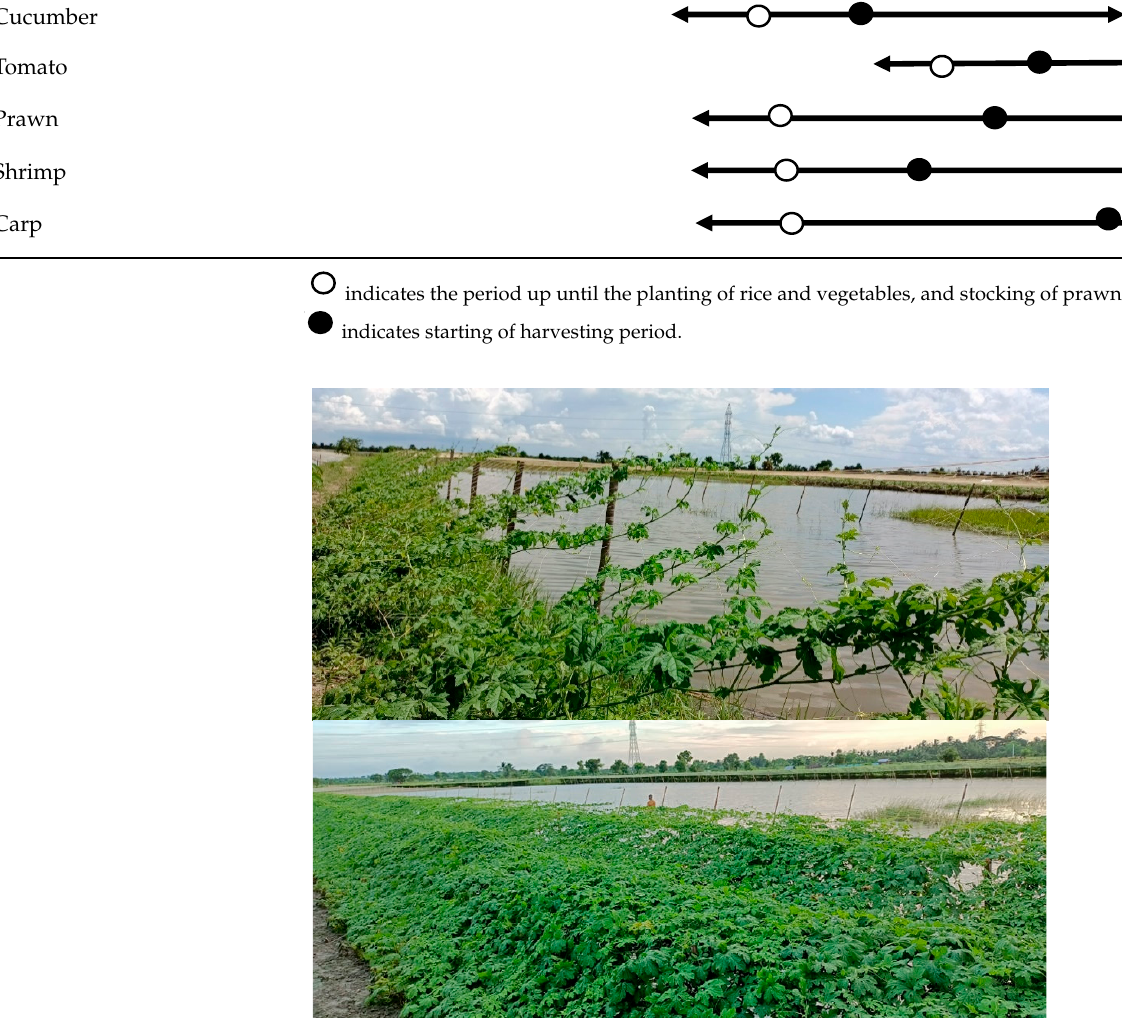
Figure 2. I ntegrated rice–prawn–vegetable farming system in wet season showing the veg- Figure 2. Integrated rice–prawn–vegetable farming system in wet season showing the vegetables on etables on the embankment (Photo by the first author). the embankment (Photo by the first